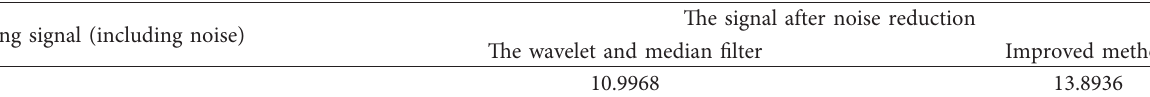
Table 1: The SNRs of the simulation signal before and after denoising (dB).